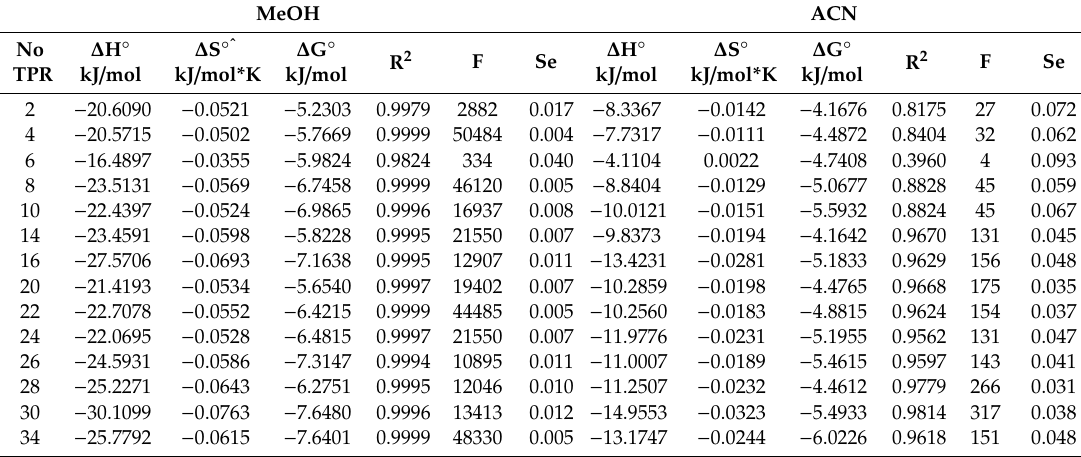
Table 3. Thermodynamic parameters obtained for investigated compounds by the use of the teicoplanin stationary phase and 15% organic-aqueous eluents with methanol or acetonitrile.